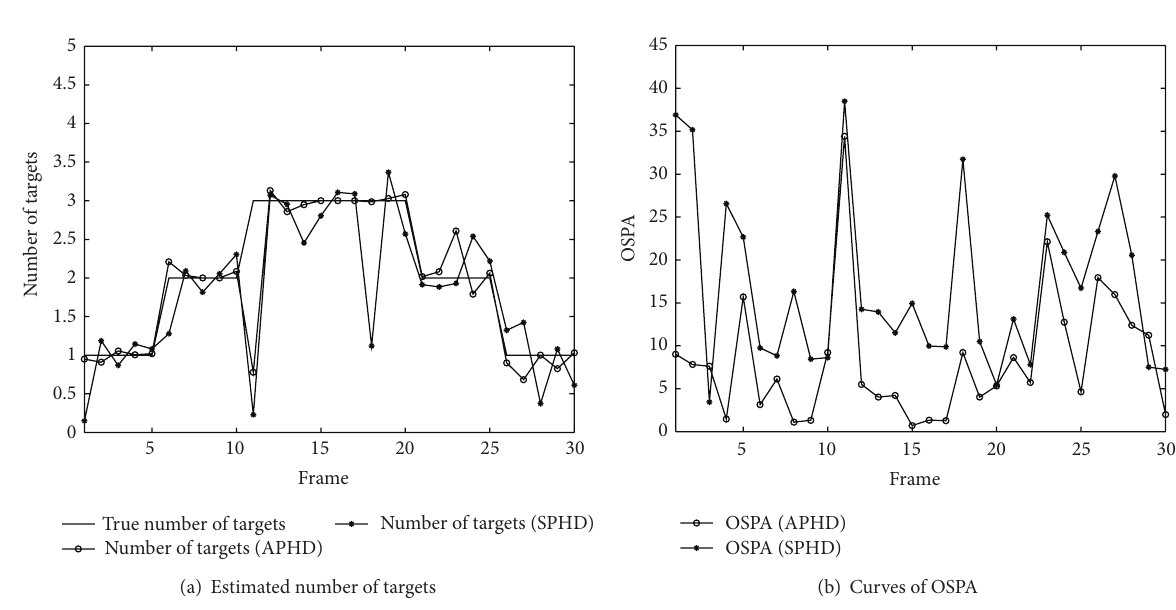
Figure 11: The performance comparison of APHD filtering and SPHD filtering (SNR = 8.7